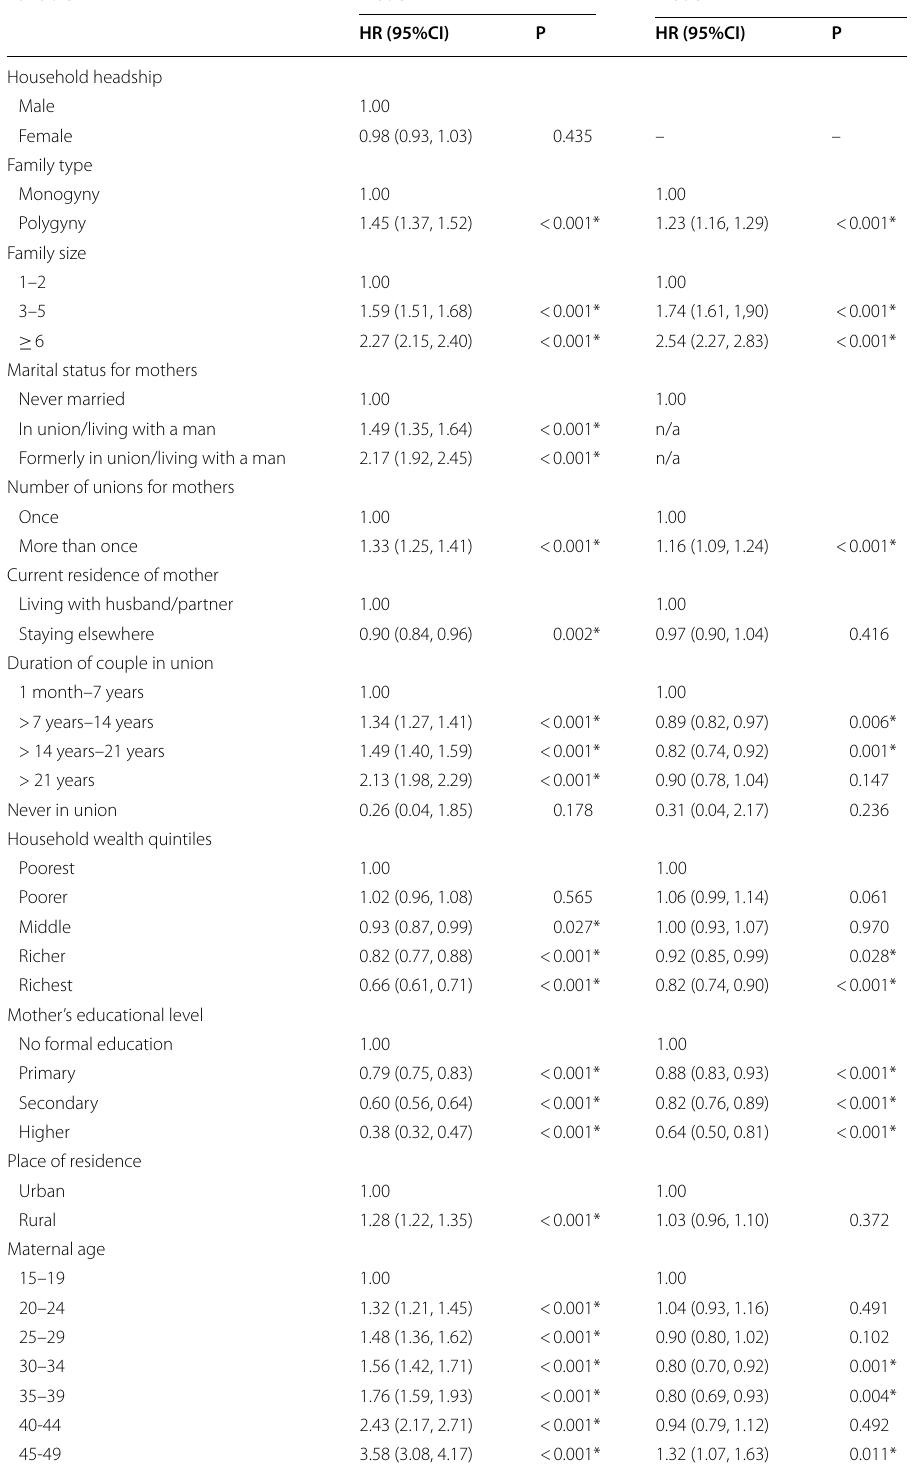
Table 3 Household factors associated with infant mortality in SSA; DHS 2008–2017